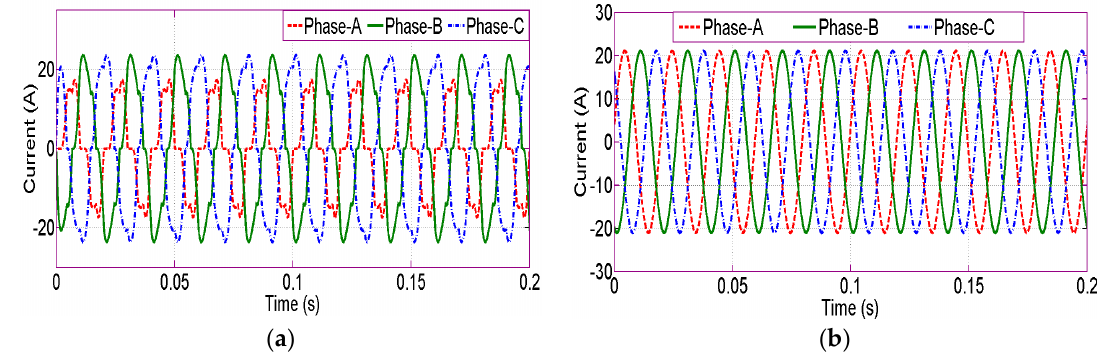
Figure 23. The results of digital simulation under unbalanced voltage and current conditions: ( a ) Unbalanced distorted load currents ( b ) Compensated source current after SPV-UPQC connection.